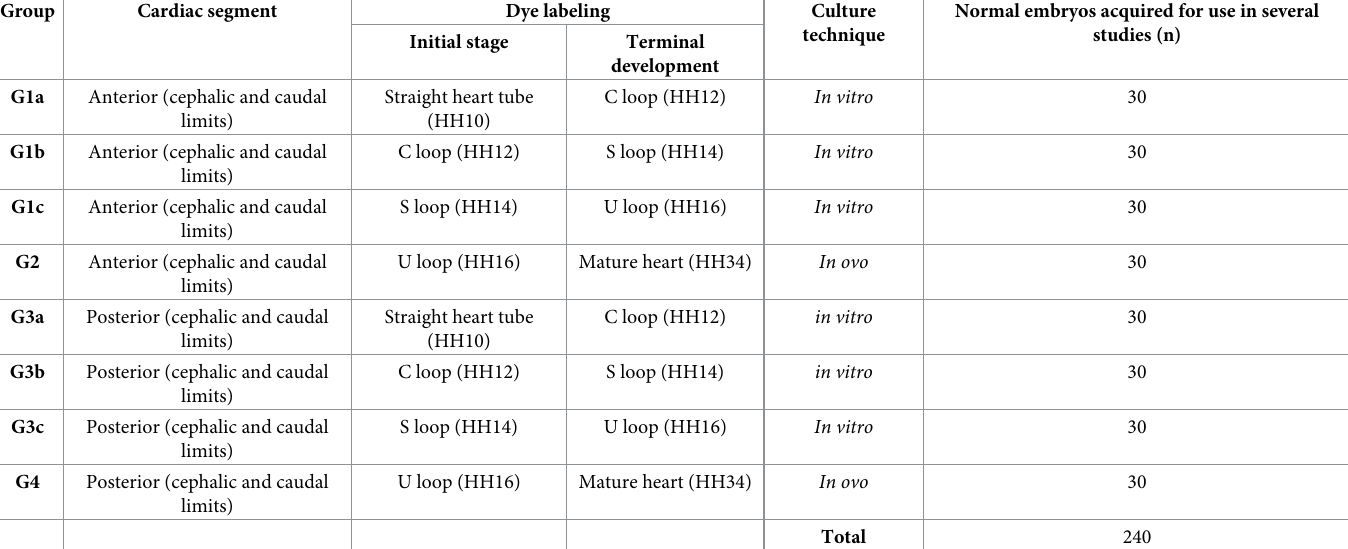
Table 1. Study group features and embryos